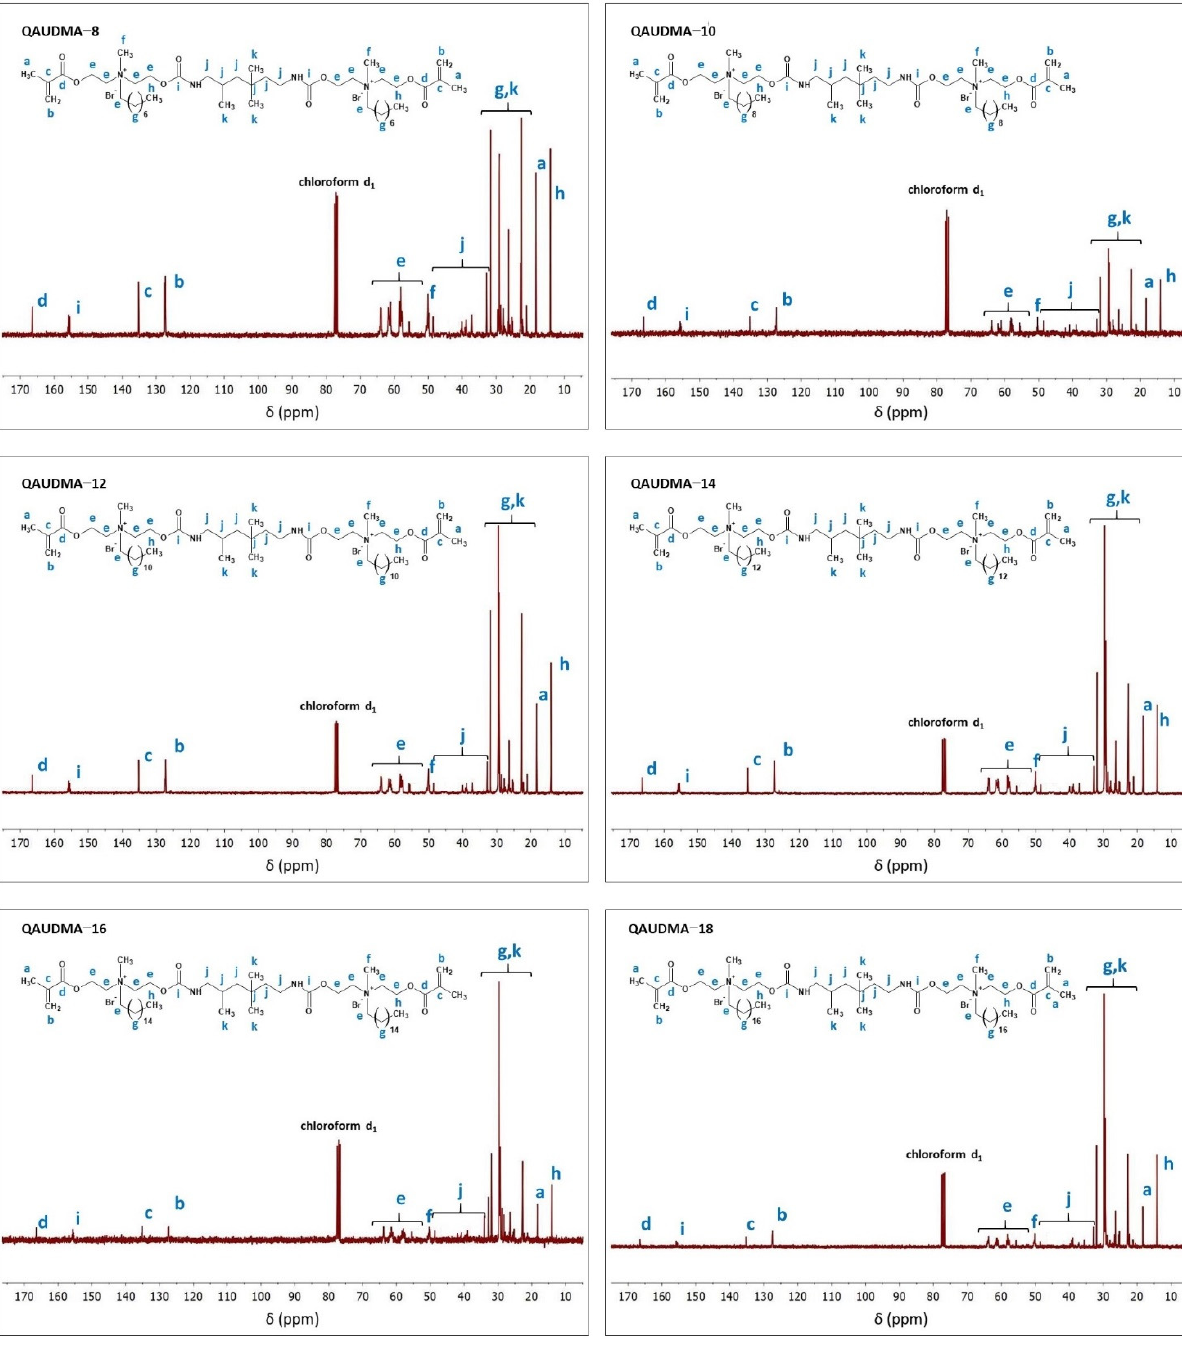
Figure 6. 13 C NMR spectra of QAUDMAs.